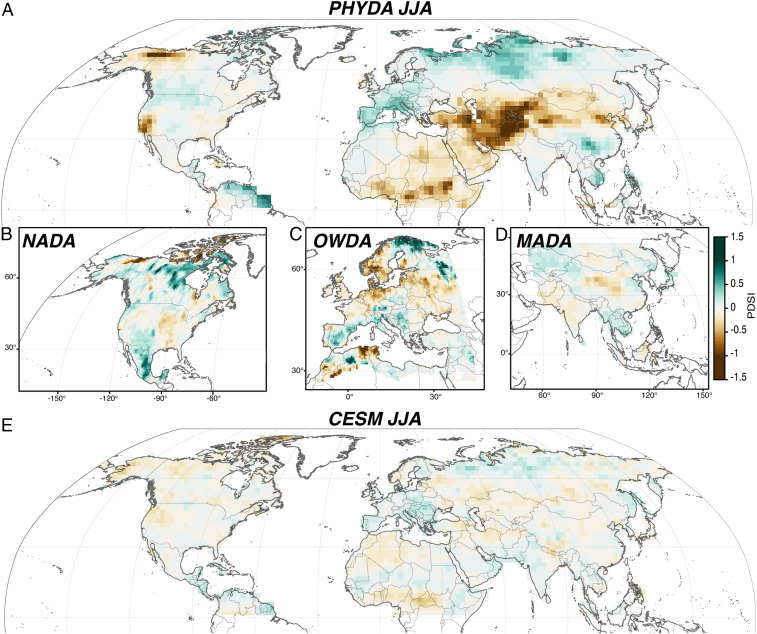
A comparison of JJA hydroclimatic responses estimated from PHYDA and drought atlases in the Northern Hemisphere. (A) The weighted mean (years +0 to +20) state of Northern Hemisphere hydroclimate after TVEP in JJA using PHYDA. (B) As in A, but using the NADA (49) and domain instead. (C) As in A, but using the OWDA (48) and domain instead. (D) As in A, but using the MADA (50) and domain instead. (E) As in A, except for CESM ensemble member 10. Note that MADA starts in 1300 CE, and thus only seven events were included in the SEA in D. Values that do not satisfy the significance threshold (P < 0.05) are excluded.